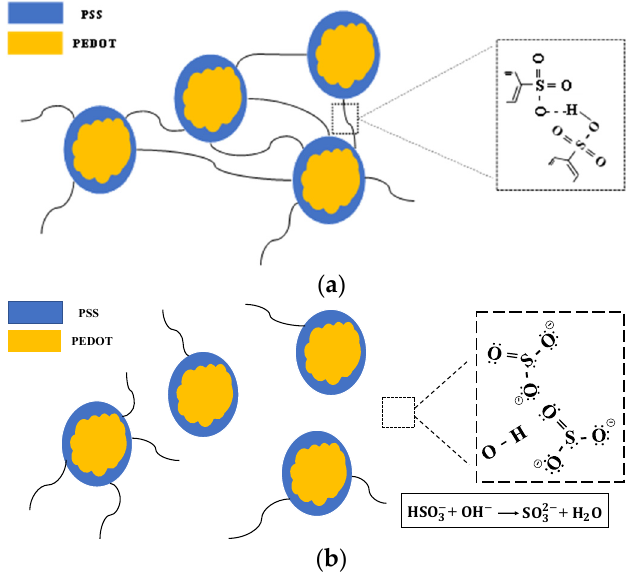
Figure 3. ( a ) A schematic of the hydrogen bond between hydrogen sulfite groups of the PEDOT: PSS. ( b ) A schematic of the hydroxyl group reaction with hydroxyl sulfite to produce sulfite ions and water after doping with organic additives. Table 2. Transmittance and haze of PEDOT: PSS doped with various percentage concentrations (wt%) of sorbitol and maltitol.